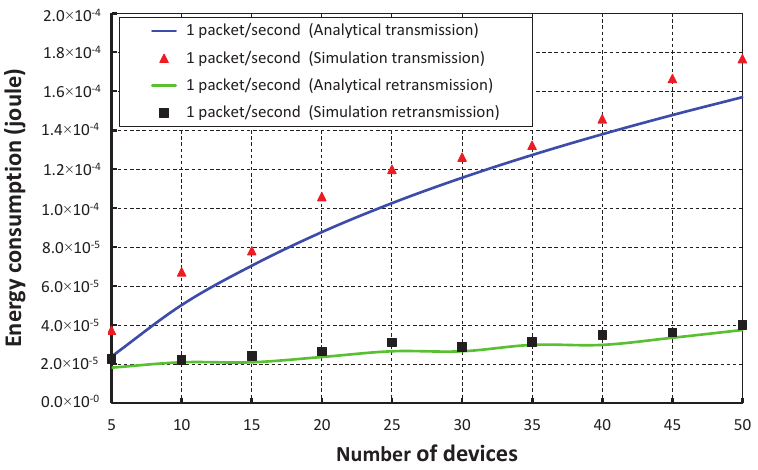
Figure 19. Validation of the energy consumption of our proposed scheme for different numbers of devices.